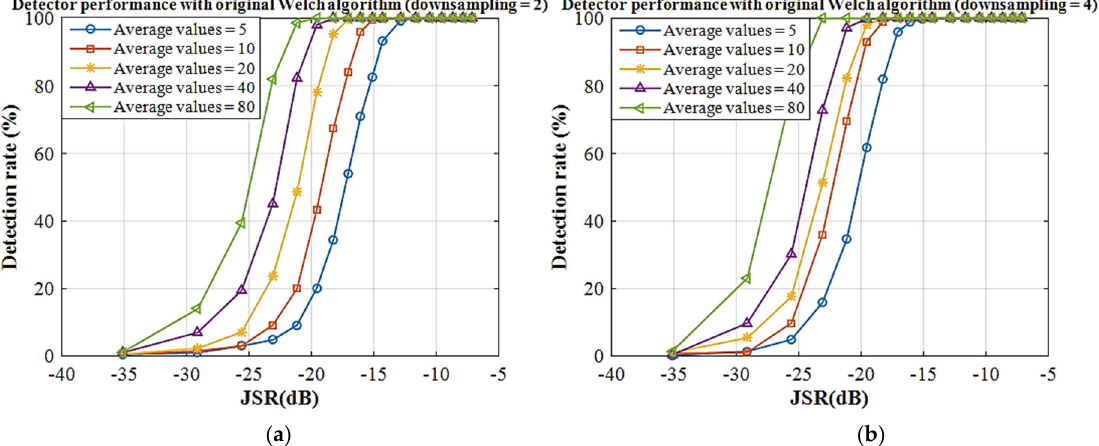
Figure 12. Correct detection percentage based on the input JSR (detector with the original Welch method); ( a ) downsam- Figure 12. pling = 2; ( b ) downsampling = 4.